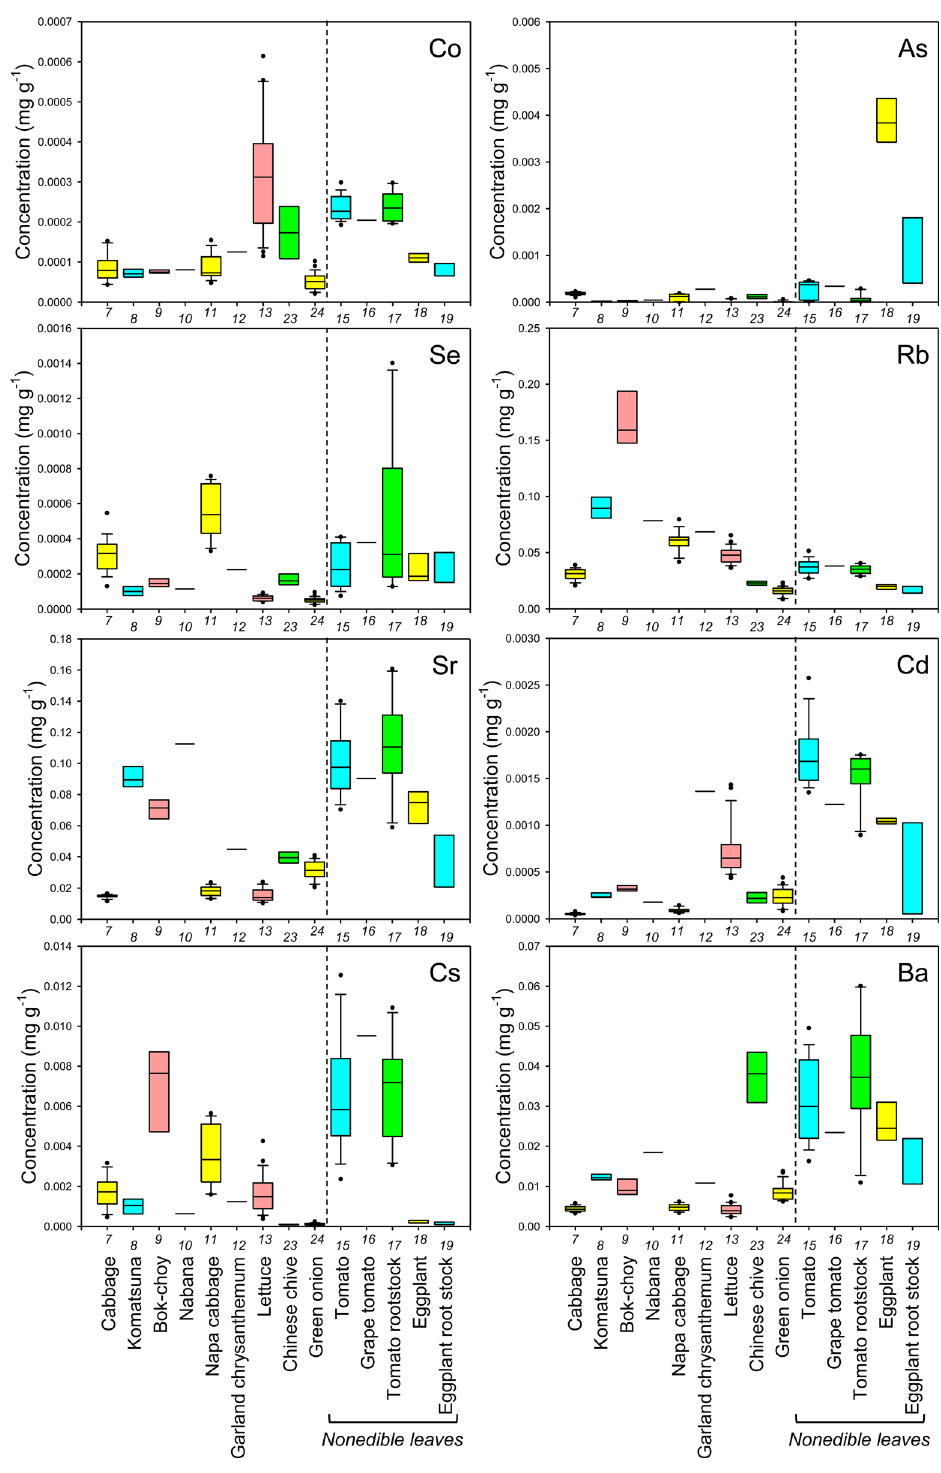
Fig 3. Boxplots showing the concentration of Co, As, Se, Rb, Sr, Cd, Cs, and Ba in leaves of various crop species. Concentrations in nonedible leaves are also shown. Numbers in x-axis indicate the species number in Table